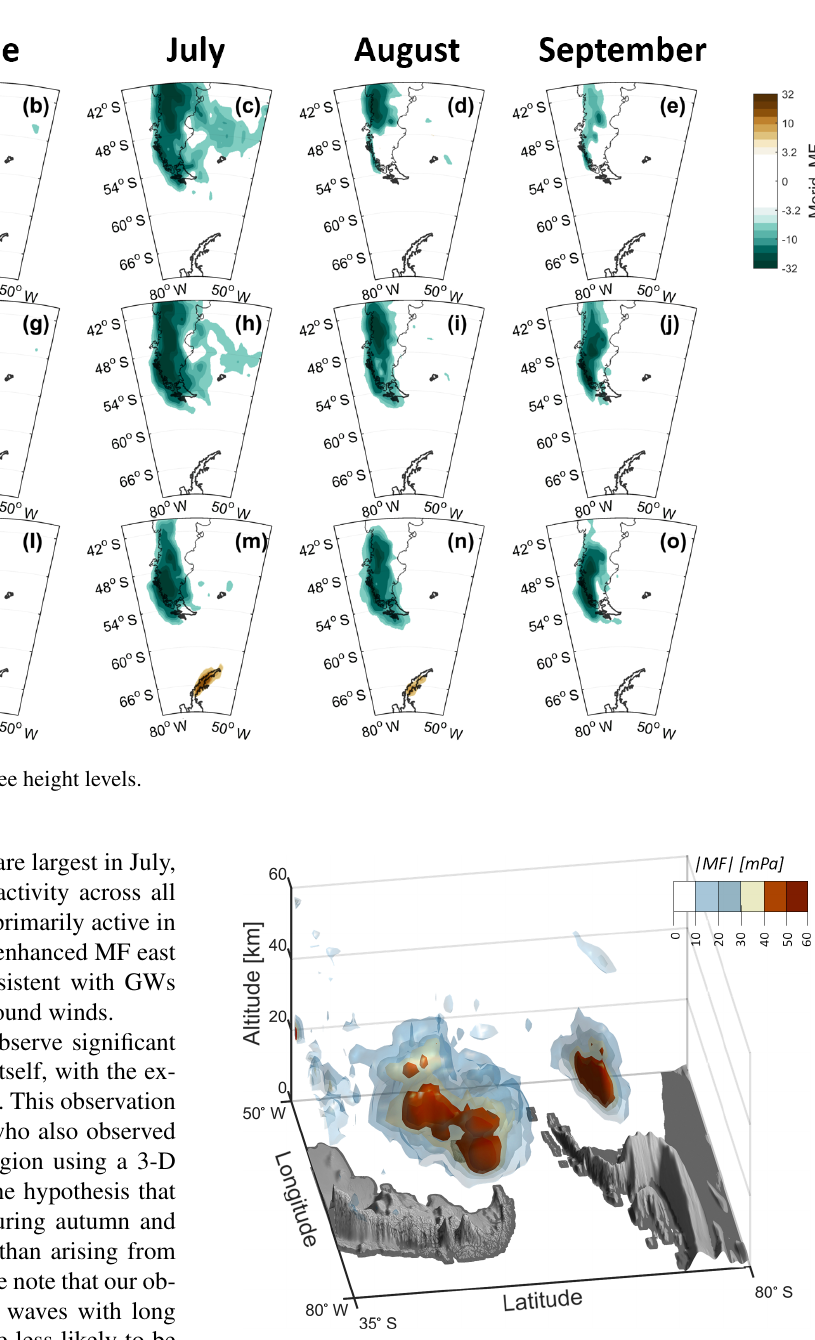
Figure 9. Mean 3-D | MF | for August